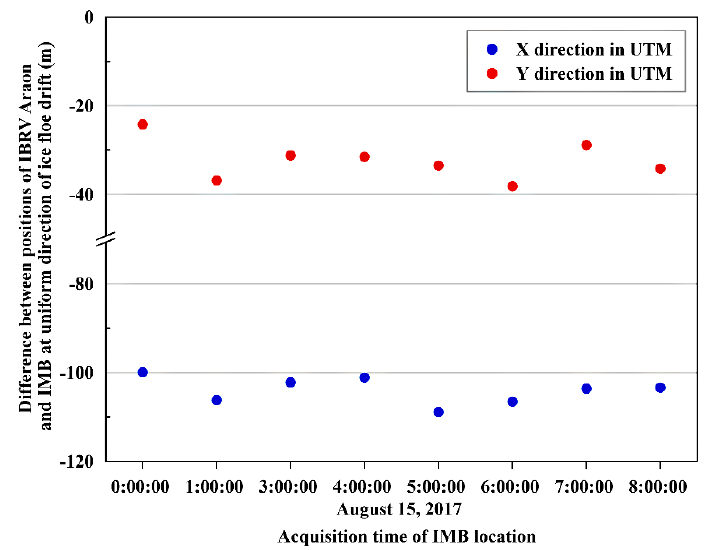
Figure 10. Comparison between the geographic coordinates of trajectories from the IBRV Araon anchored to the main ice and from the ice mass balance buoy (IMB) deployed on the same ice floe, recorded at the time of consistent heading direction.